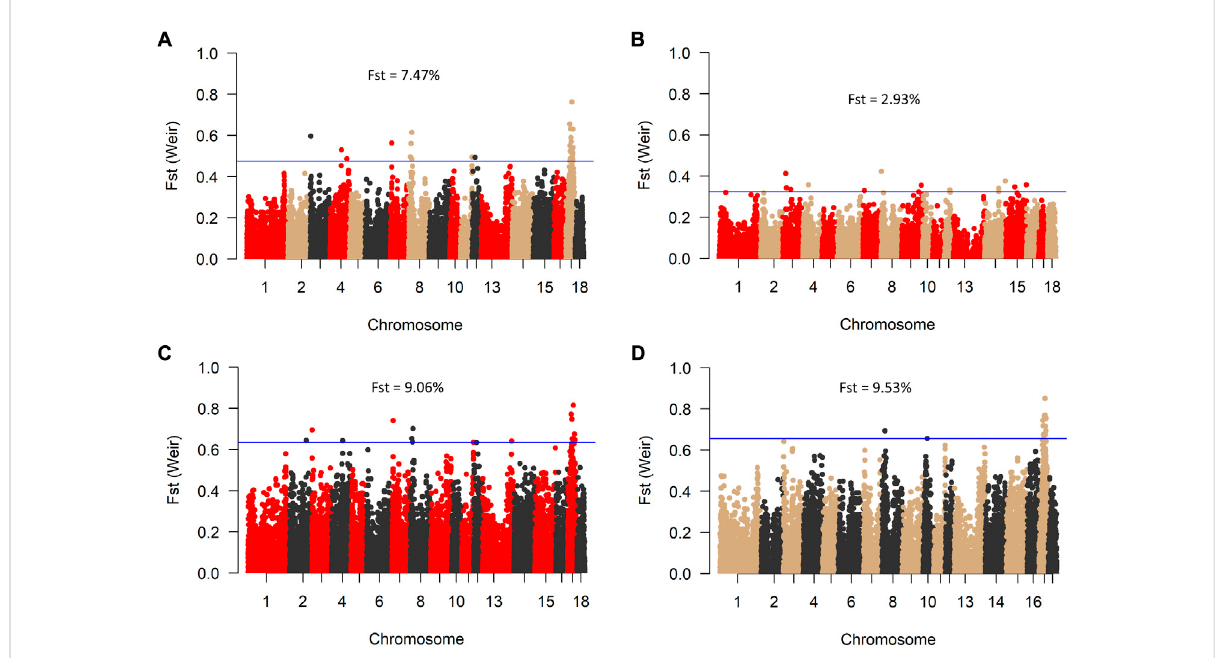
FIGURE 4 Manhattan plot of genome-wide Fst values between BM, RM and SM (A) ; RM and BM (B) ; RM and SM (C) , and BM and SM (D) . The blue line indicates genome-wide signi fi cant threshold above which SNPs were considered signi fi cant for candidate gene identi fi cation. Mean Fst values for each comparison is speci fi ed in